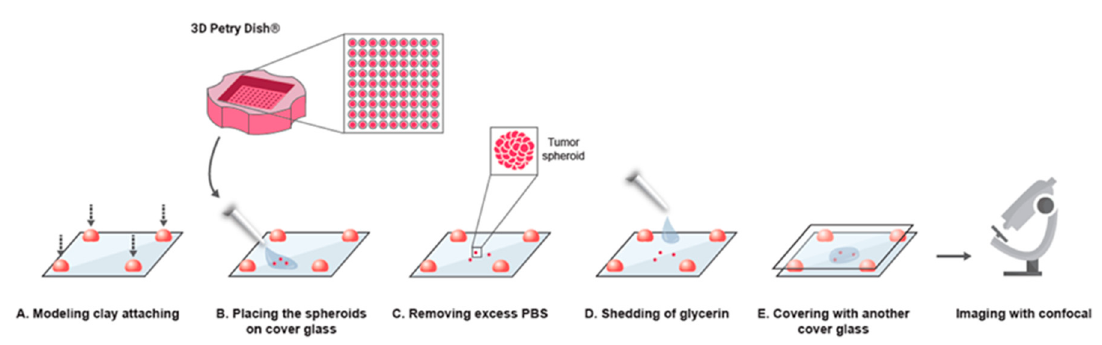
Figure 1. Illustration of the clearing procedure and the technical steps carried out prior to confocal imaging. In the first step, ~0.5 × 0.5 cm of modeling clay is attached on each corner of the cover glass and a drop of PBS containing 2–3 spheroids is gently spread in the center of the cover glass. The remaining PBS solution is removed and 50 µL of 85% glycerin is added on top of the spheroid sample. An additional cover glass is placed precisely and carefully on top and is then pressed slightly to allow ~1 mm space between the 2 cover glasses, enabling convenient and improved confocal imaging to be performed.